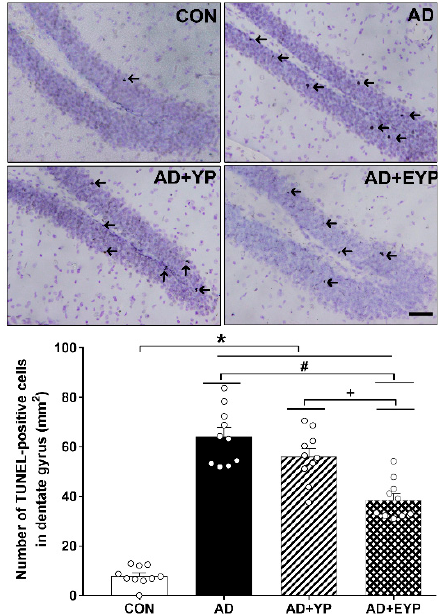
Figure 6. Effect of plasma from young exercised mice on cell death in the hippocampal dentate gyrus (DG). Photomicrographs and data of TUNEL-positive cells (arrow). The scale bar represents 50 µm. CON: wild-type, AD: 3xTg-AD, AD + YP: 3xTg-AD and young plasma injection, AD + EYP: 3xTg-AD and exercised young plasma injection group. Data are expressed as the mean ± standard error of the mean (SEM). * p < 0.05 compared to the CON group. # p < 0.05 compared to the AD group. + p < 0.05 between AD + YP and AD + EYP groups.